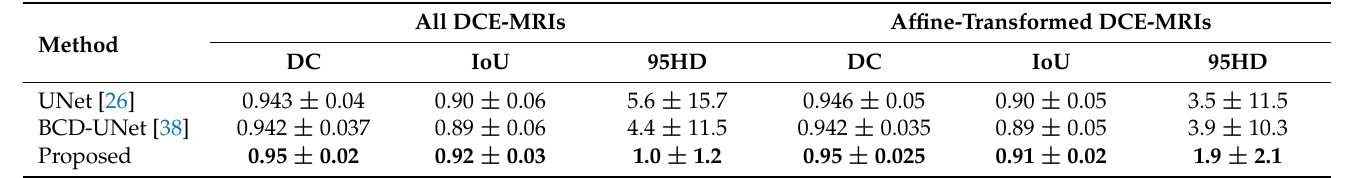
Table 2. Performance of the proposed approach versus that of the UNet and BCD-UNet